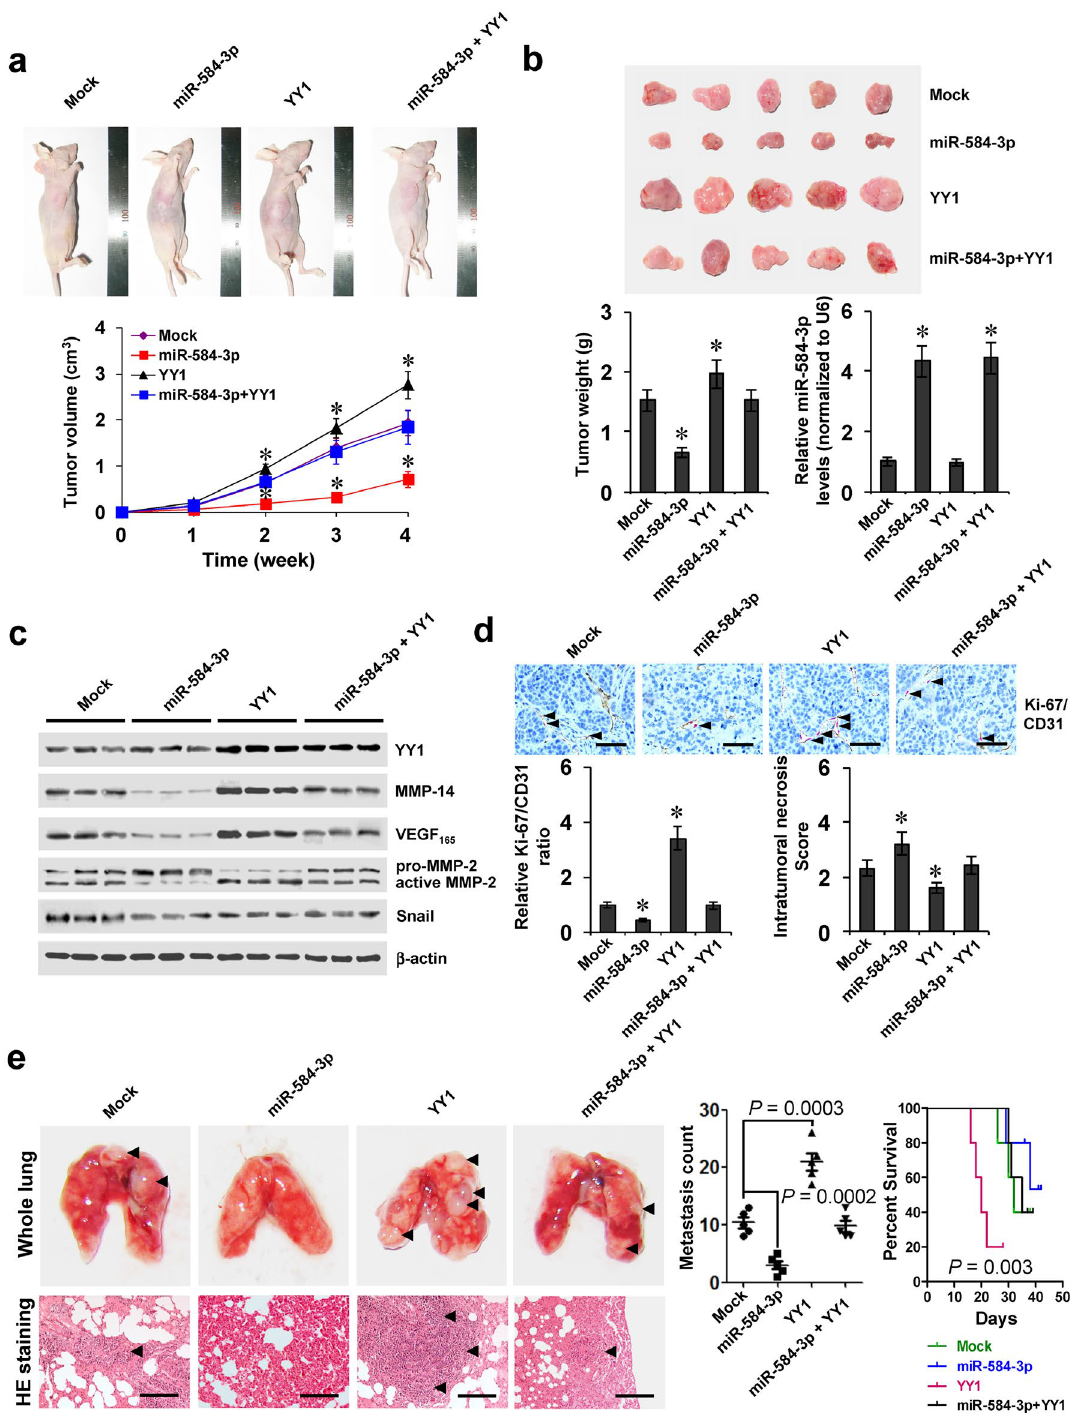
Figure 5. miR-584-3p attenuates the YY1-facilitated growth, metastasis, and angiogenesis of gastric cancer cells in vivo . ( a ) Tumor growth curve of SGC-7901 cells (1 × 10 6 ) stably transfected with empty vector (mock) or miR-584-3p precursor, and those co-transfected with YY1 in athymic nude mice (n = 5 for each group), after hypodermic injection for 4 weeks. ( b ) Representative images (top), weight (bottom), and miR-584-3p levels (bottom) of xenograft tumors formed by hypodermic injection of SGC-7901 cells stably transfected with mock or miR-584-3p precursor, and those co-transfected with YY1 (mean ± SD, n = 5). ( c ) Western blot showing the expression of YY1, MMP-14, VEGF 165 , and MMP-2 within tumors formed by hypodermic injection of SGC-7901 cells stably transfected with mock or miR-584-3p precursor, and those co-transfected with YY1 (mean ± SD, n = 5). ( d ) Double immunohistochemical staining (top) and quantification (bottom) of Ki-67 (red, arrowheads)/CD31 (brown) expression and necrosis area within tumors formed by hypodermic injection of SGC-7901 cells stably transfected with mock or miR-584-3p precursor, and those co-transfected with